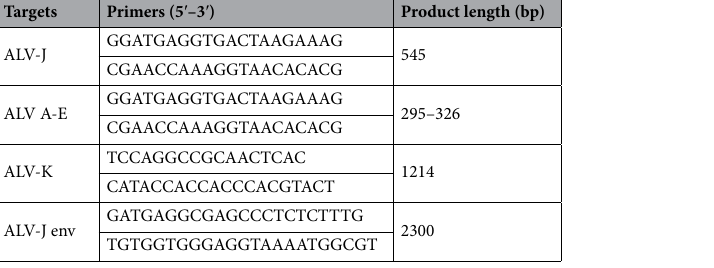
Table 5. Primers used in this